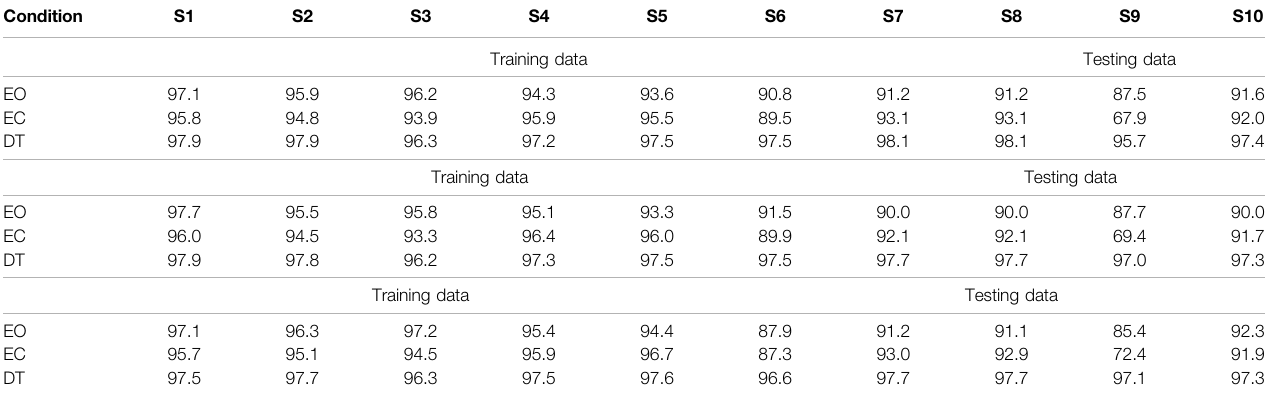
TABLE 3 | NMRSE fi tting percentages obtained by the models identi fi ed for each experimental condition. Condition